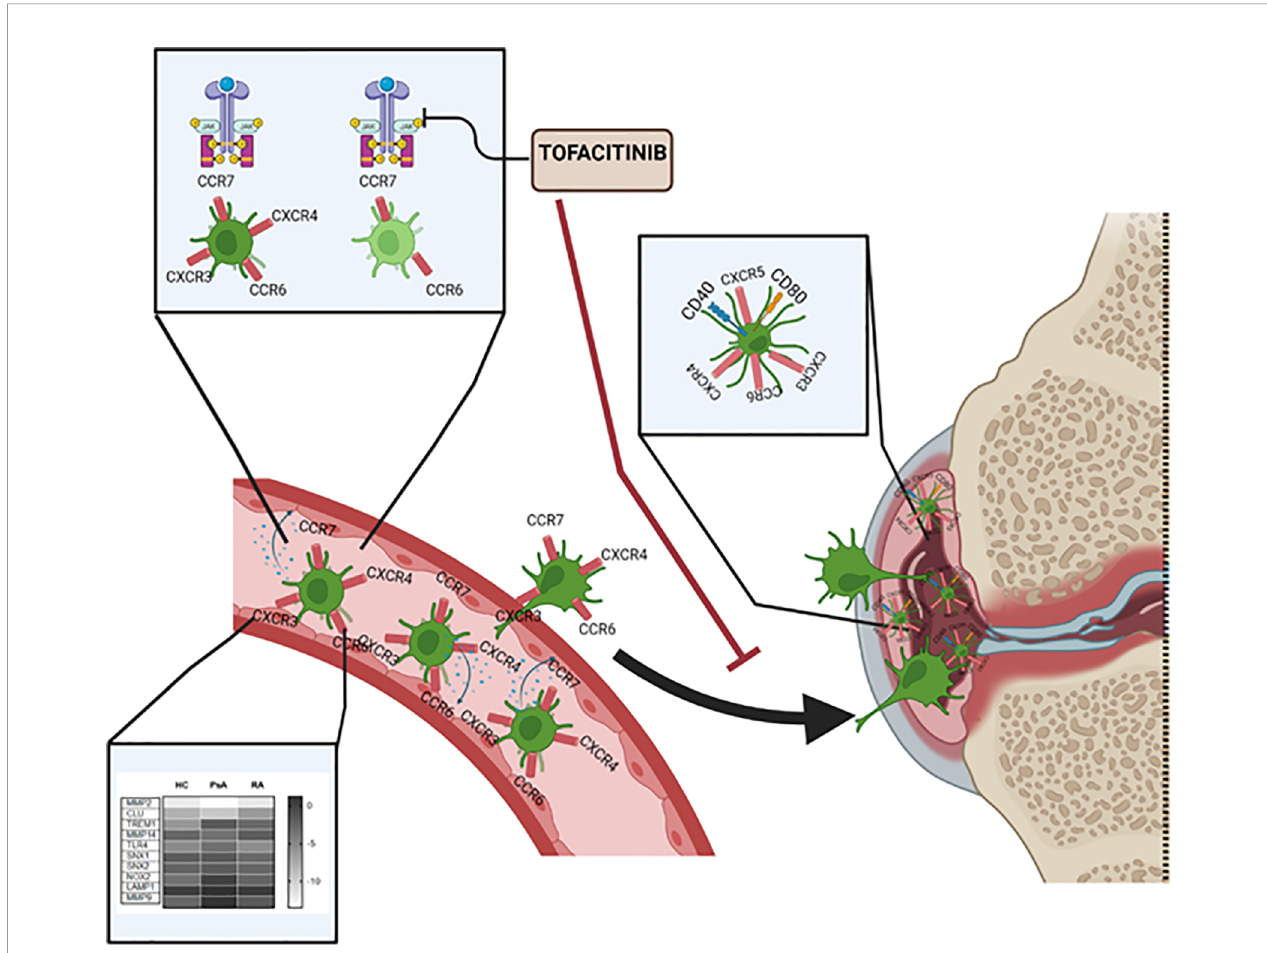
FIGURE 6 | Graphical summaryofkey results described within the manuscript. CD209/CD14 + DCinthe circulation ofPsA and RA patients present increased frequency, cytokine production andchemokine receptors compared to healthyindividual. The CD209/CD14 + DCare enriched in the IA joint wherethey are further activated,possibly by in fl ammatory mediatorspresent in the fl uid,and exhibita unique mature andmigratory phenotype, as observed by the increase inCD40 andCD80, and inchemokine receptors alone orin combinations. Key transcriptionaldifferences incirculatory CD209 + DCfrom RA and PsA patients were observed, inparticular in genes involved in endocytosis/antigen presentation.Tofacitinib speci fi cally targets the development, functional capacity and migration ofCD209/CD14 +